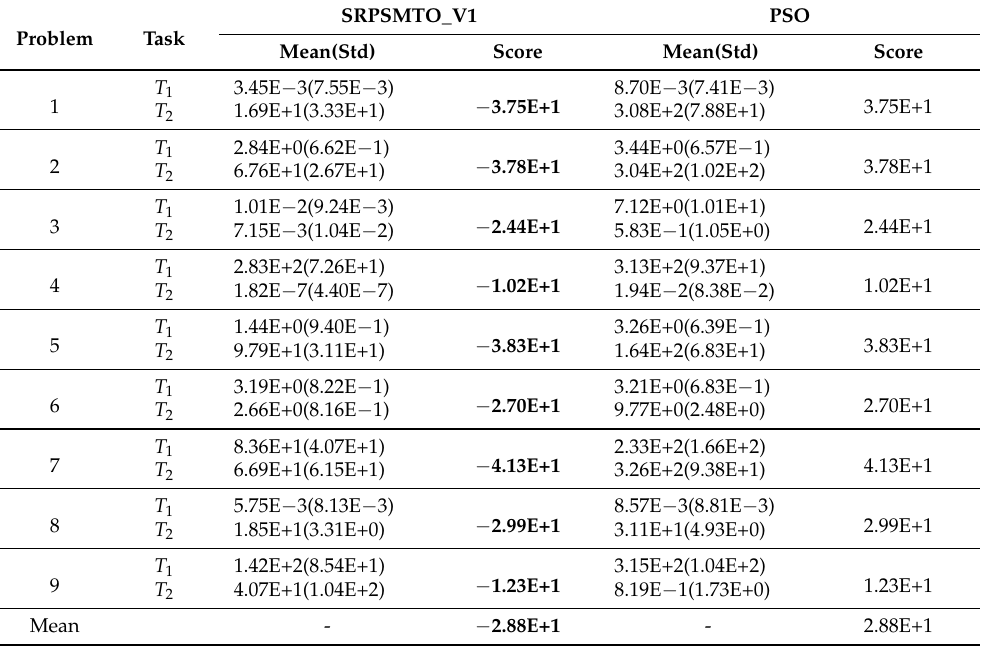
Table 3. Comparison of SRPSMTO (SRPSMTO_V1) and PSO in terms of the means, bracketed standard deviations and scores of the best achieved FEVs over 30 runs on test suite 1. The better results are shown in bold.